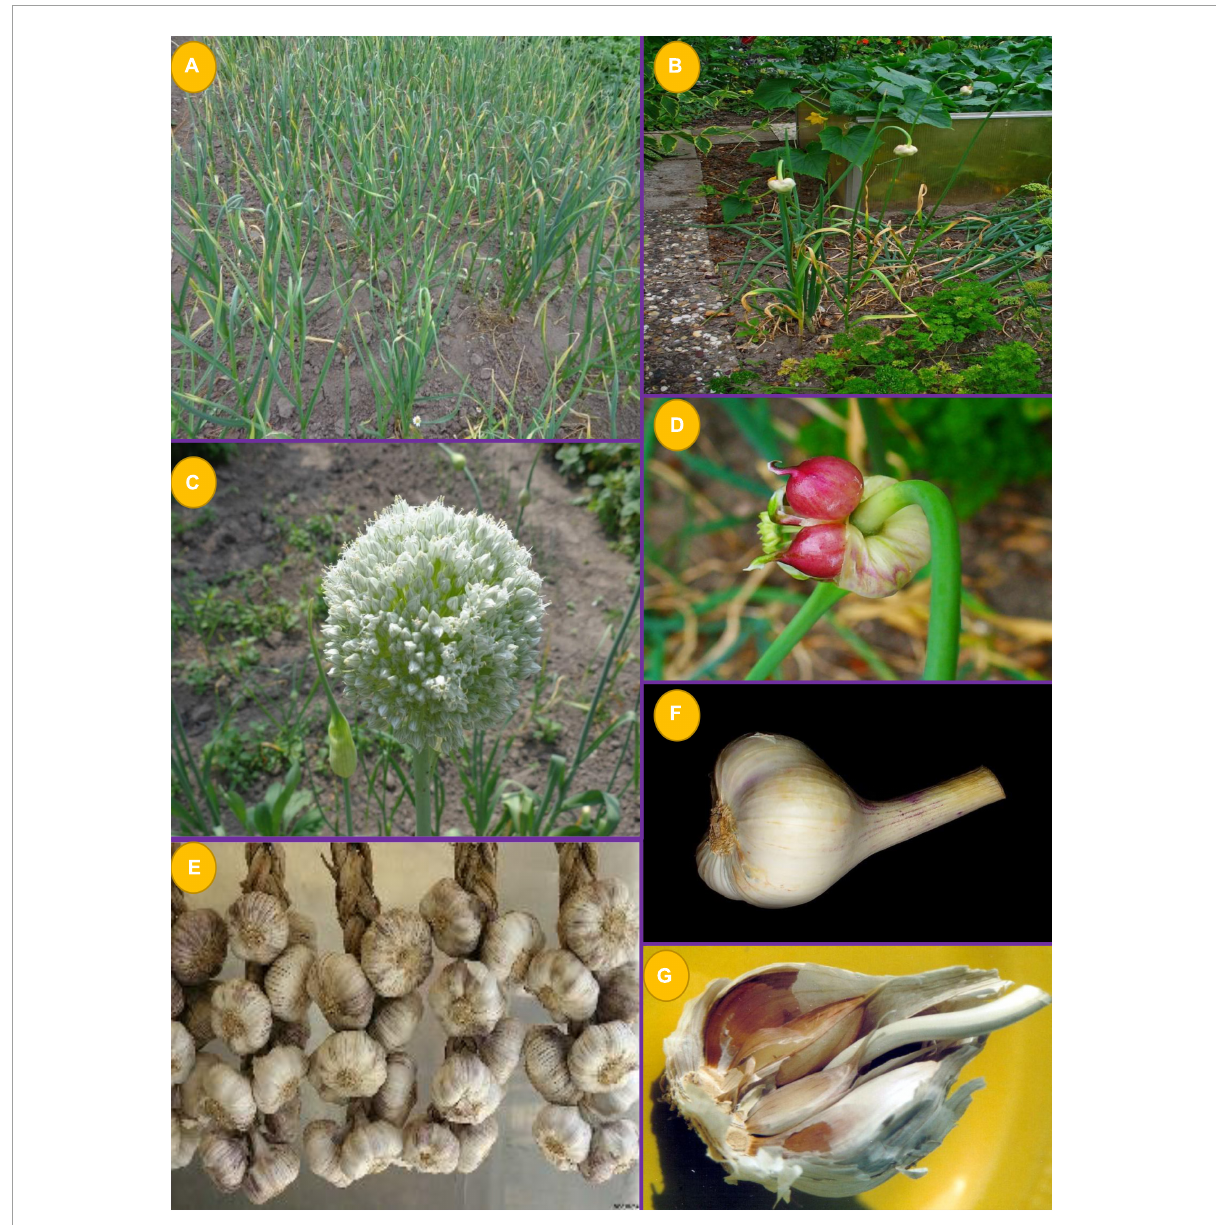
IUPAC names. Figure 2 represents the chemical structures of phytochemicals (obtained from ChemSpider and